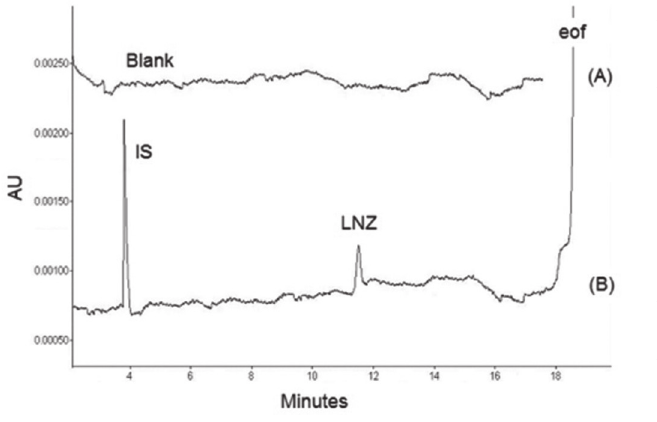
FIGURE 2 - CZE of (A) – Blank sample, (B) - linezolid (chemical reference). CE/UV conditions: 100 mM formic acid, pH 3.0, applied voltage +30 kV, injection by pressure (0.5 psi for 10s) and detection at 254 nm. Caption: methanol as eof marker and imidazole as IS (internal standard).